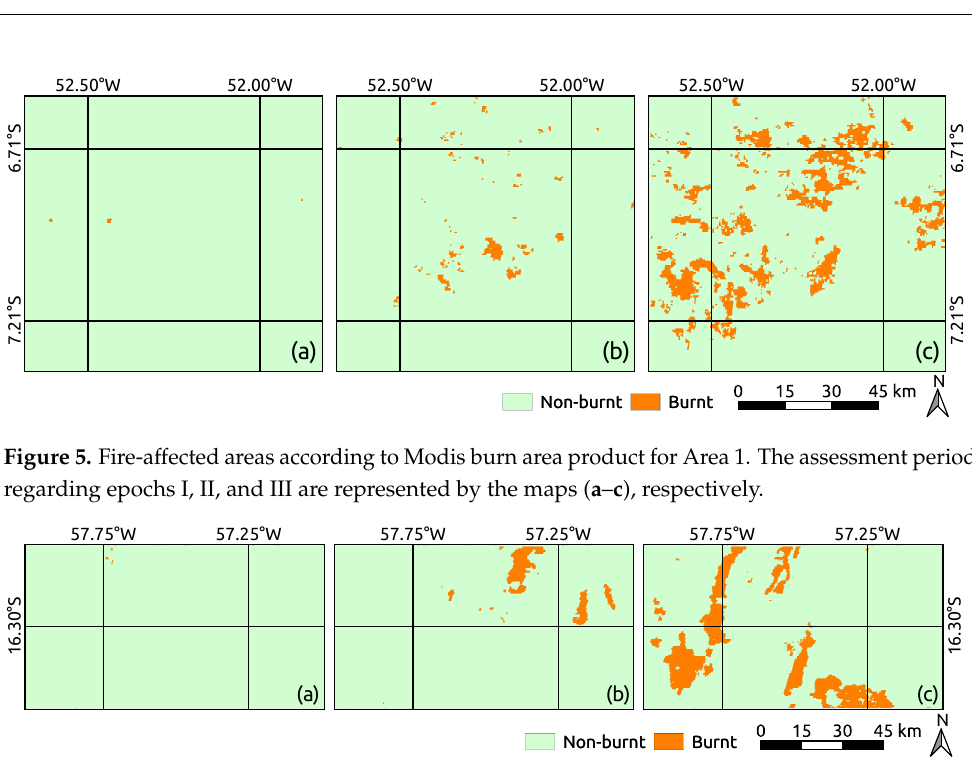
Figure 6. Fire-affected areas according to Modis burn area product for Area 2. The assessment periods regarding epochs I, II, and III are represented by the maps ( a – c ),